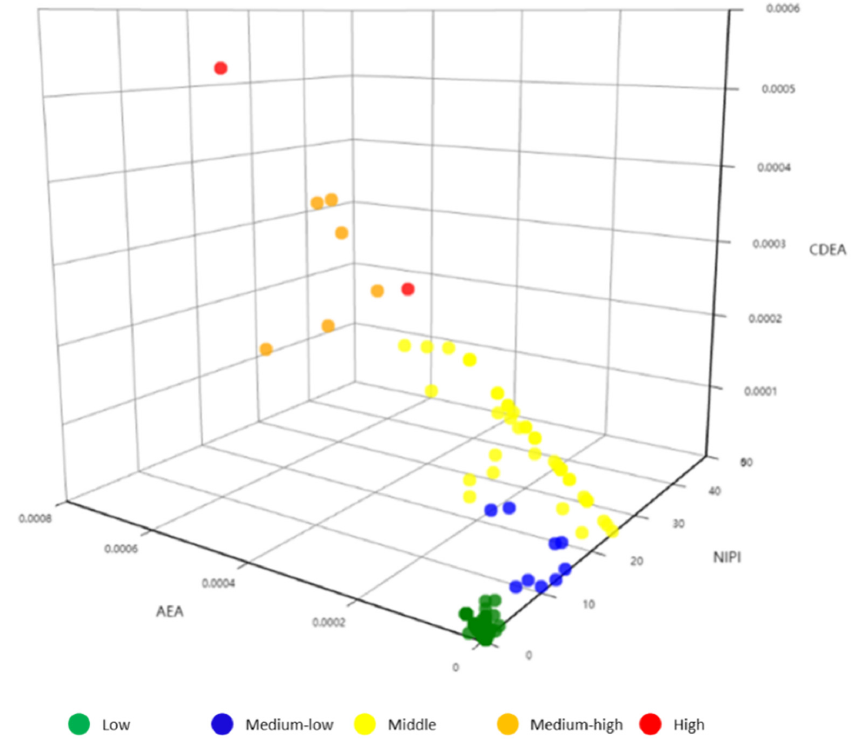
Figure 5. K-means++ clustering results.